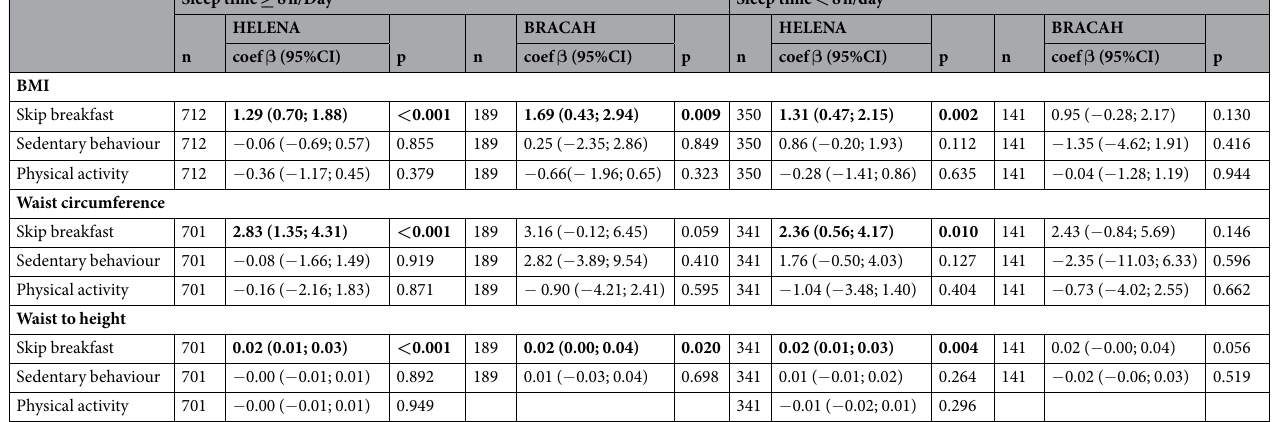
Table 4. Adjusted * association between EBRBs and general and abdominal obesity stratified by sleep time among adolescents’ boys studied from HELENA-CSS and BRACAH study. Adjusted by potential confounders: center (only in HELENA − CSS), age and education mother. Significant associations are in bold. EBRBs: energy balance-related behaviours, BMI: body mass index, HELENA-CSS: Healthy Lifestyle in Europe by Nutrition in Adolescence cross-sectional study, BRACAH study: Brazilian Cardiovascular Adolescent Health study, CI: confidence interval, coef β : beta